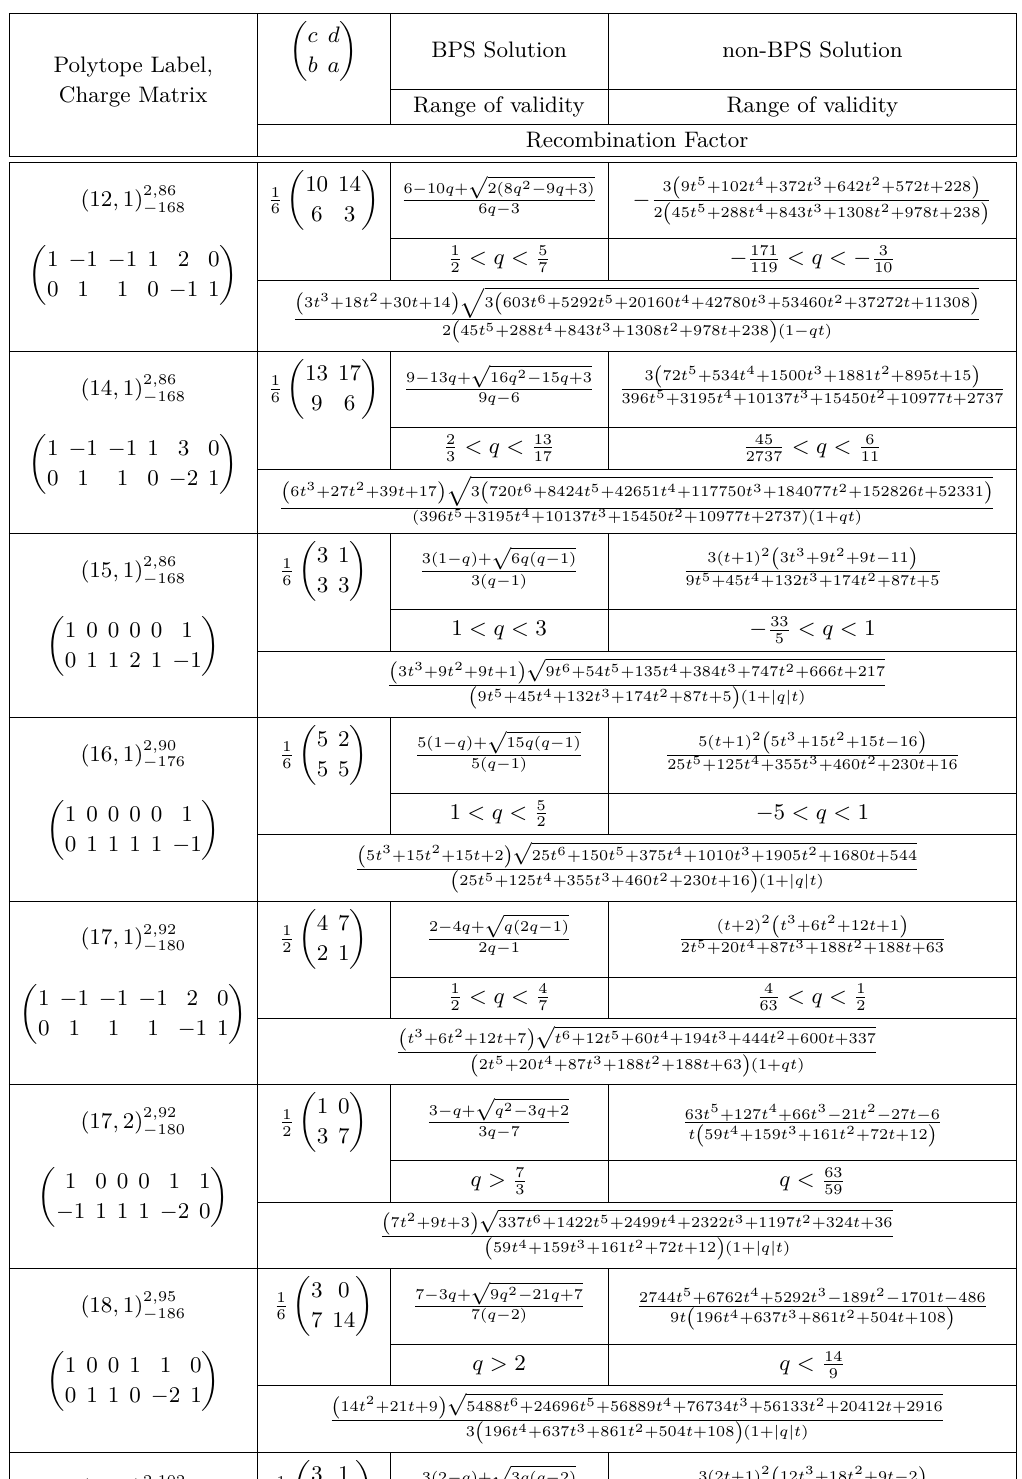
Table 5 . BPS and non-BPS extremal black holes in one-modulus THCY models, 2/5.